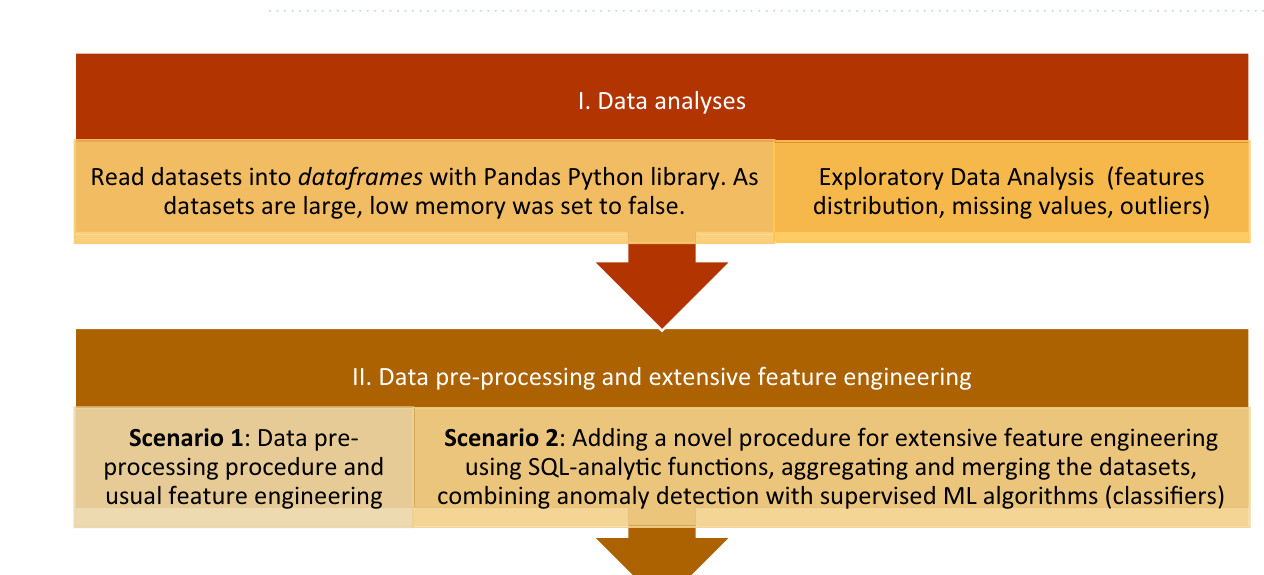
Table 1. Characteristics of other scientific research papers on the electricity consumption fraud detection.